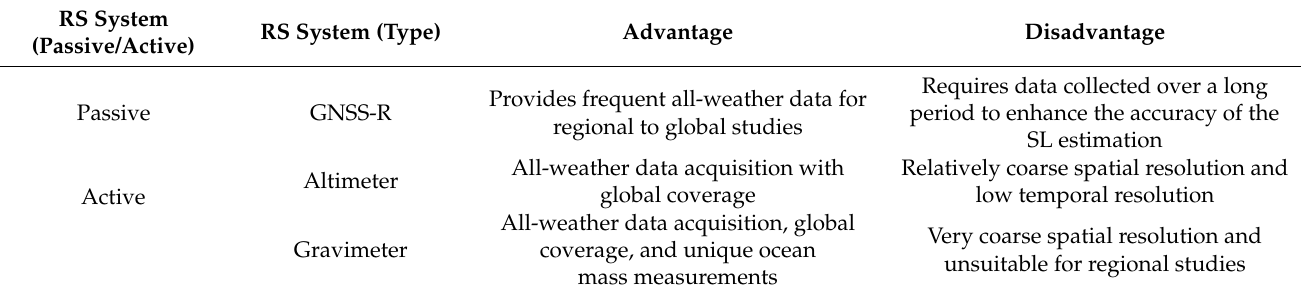
Table 4. Different RS systems for SL Mapping along with their advantages and